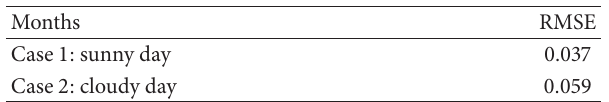
Table 6: Comparison between simulation results on sunny day and cloudy